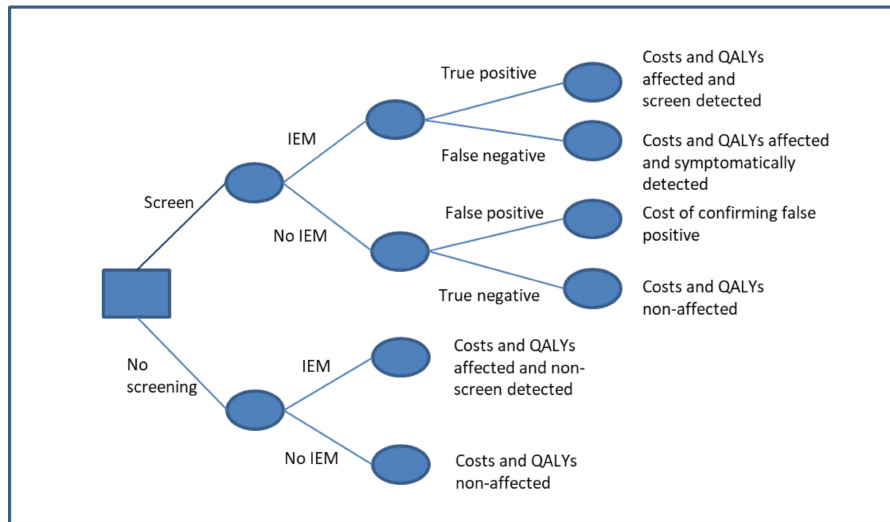
Figure 1. Model diagram. The figure represents the model